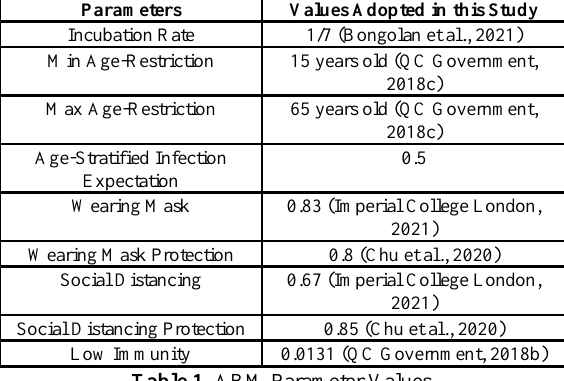
Table 1. ABM Parameter Values